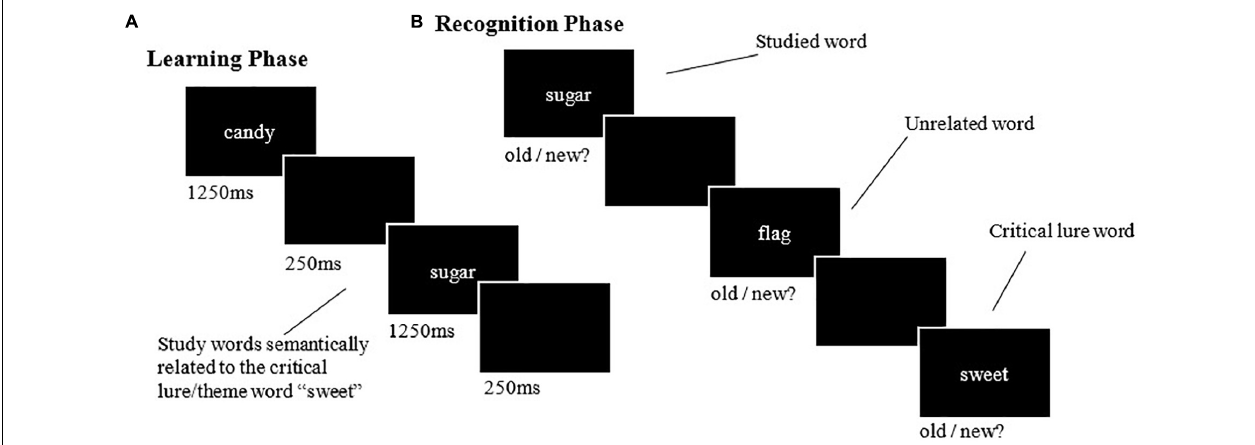
FIGURE 1 | Example learning and recognition trials from the DRM paradigm. (A) The learning phase involved viewing lists of related study words. (B) The recognition phases involved immediate and delayed recognition, which involved the presentation of study words, their respective lures, and control words, to which participants made a self-paced old/new